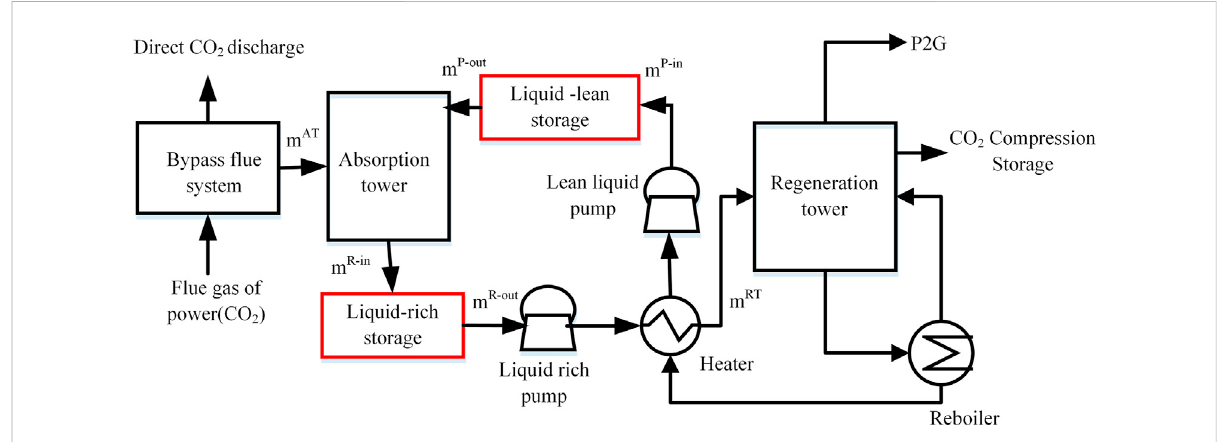
FIGURE 1 Main structure of LSCCS.